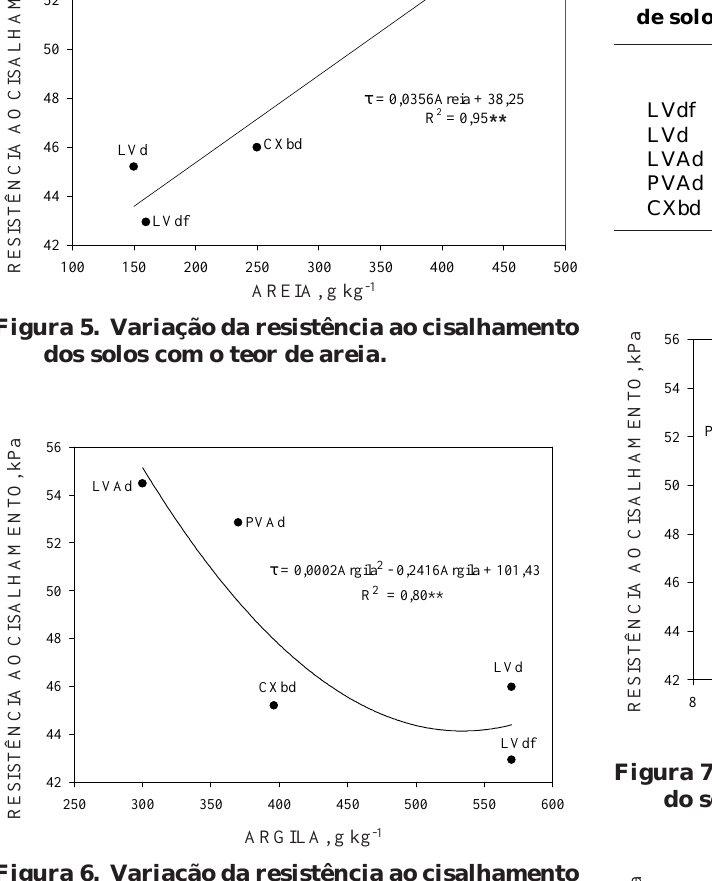
Figura 6. Variação da resistência ao cisalhamento dos solos com o teor de argila.